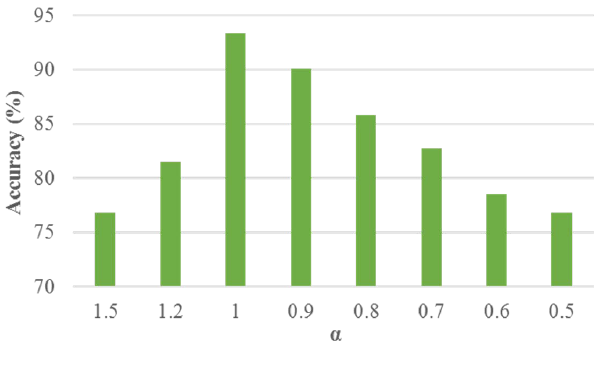
Figure 4. The classification accuracies (%) of the proposed JFCNN with different α .